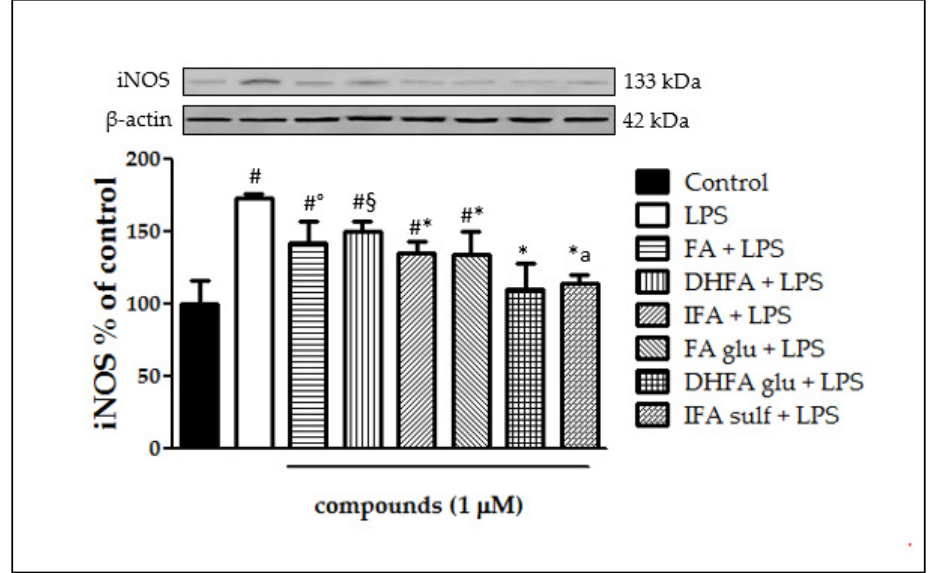
Figure 2. Level of iNOS dosed by Western blot and reported as percentage of the control, in Caco ‐ 2 cells treated with lipopolysaccharide (LPS) (1 μ g/mL) for 48 h and pretreated for 30 min with FA, DHFA, IFA, FA glu, DHFA glu, and IFA sulf (1 μ M) preceding LPS co ‐ exposure. Control and LPS groups were pretreated with an equivalent volume of methanol. Each column represents the mean ± SD of the independent experiments ( n = 6). Significant differences among groups are described using different superscript symbols; * = significant vs. LPS ( p < 0.001); # = significant vs. control ( p < 0.001); ° = significant vs. LPS, DHFA glu + LPS and IFA sulf + LPS ( p < 0.01); § = significant vs. LPS ( p < 0.05), DHFA glu + LPS and IFA sulf ( p < 0.001); a = significant vs. FA glu + LPS and IFA + LPS ( p < 0.05). A representative WB picture of the experiment is shown. β‐ actin detection was used as a loading control for each sample.